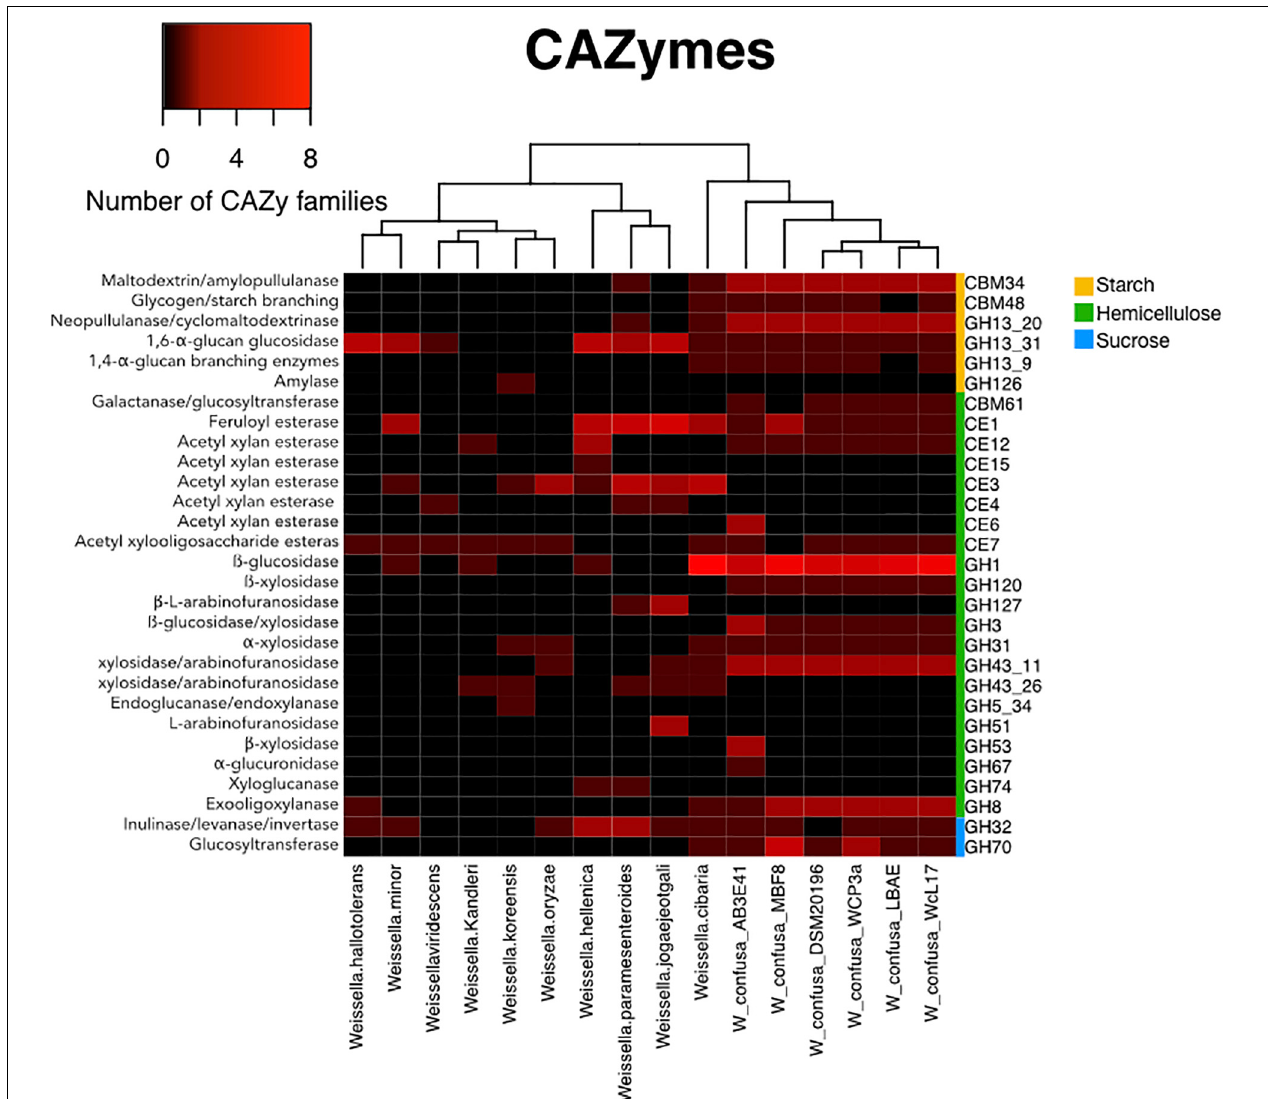
FIGURE 5 | Comparative analysis of CAZy families for representative Weissella strains ( Table 1 ), including WcL17 and WCP3a genomes. Colors within the map indicate the number of families in each genome, from zero to eight copies (black to red, respectively). The right sidebar indicates the type of substrate for each family (yellow = starch, green = hemicellulose, and blue =